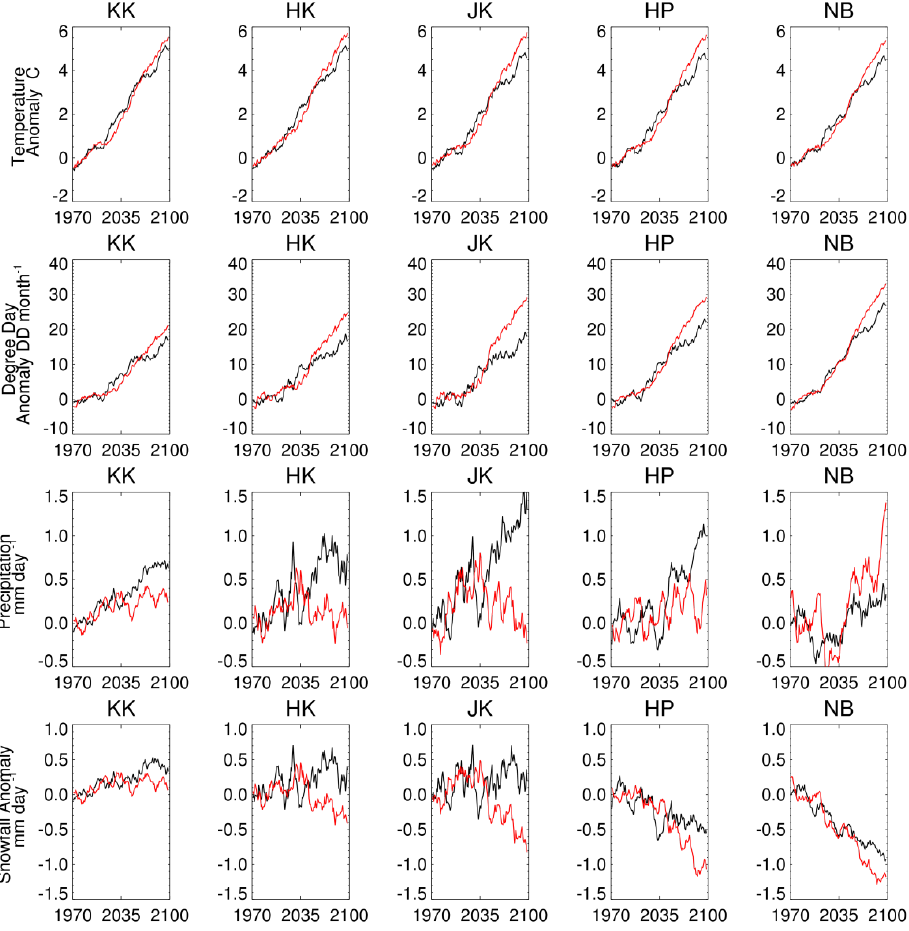
Figure 10. Projected change in annual mean air temperature, PDDs, precipitation and snowfall from the HadCM3 (black) and ECHAM5 (red) downscaled A1B simulations. Data are anomalies over the 21st century relative to 1992–2008. Data are smoothed with a 10year moving average. The regions are Hindu Kush (HK), Karakoram (KK), Jammu–Kashmir (JK), Himachal Pradesh, Uttarakhand and West Nepal (HP) and East Nepal and Bhutan (NB).